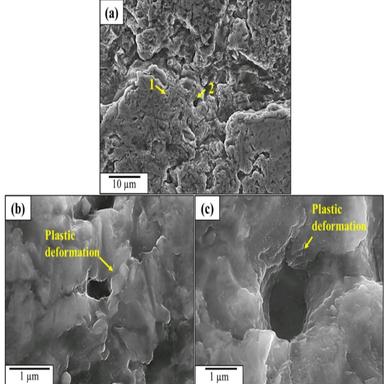
Cavities found at the tip of the leading edges (1H6 zone).